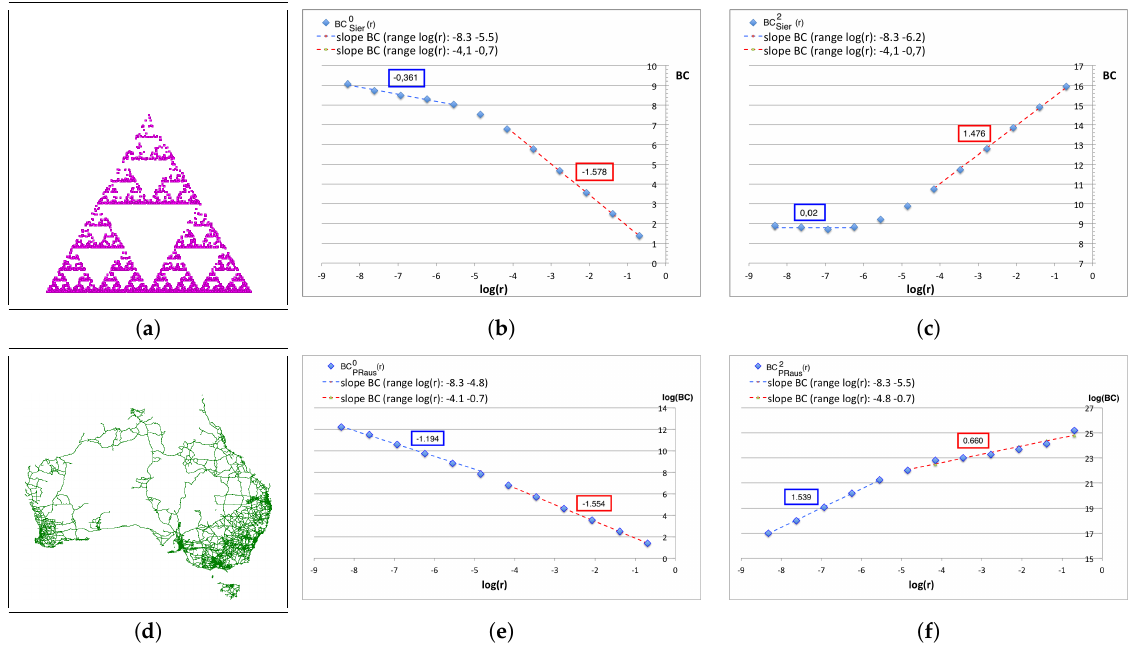
Figure 1. Example of Box-counting plot for: ( a – c ) a synthetic dataset with the distribution of a Sierpinski’s triangle, and ( d – f ) a real-world dataset representing the primary roads of